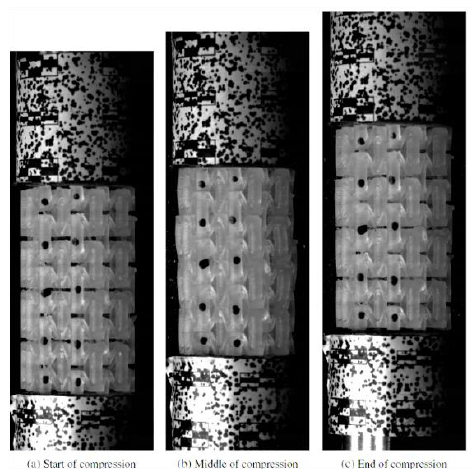
Figure 5: Examples of images obtained in SHPB